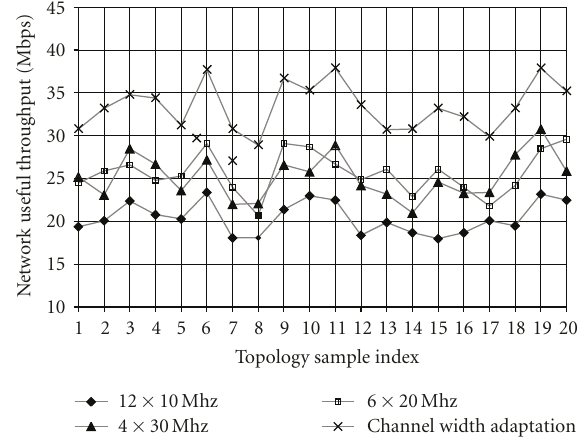
Figure 6: Comparison on the total useful throughput between Hyacinth and our algorithm across 20 randomly generated topolo-